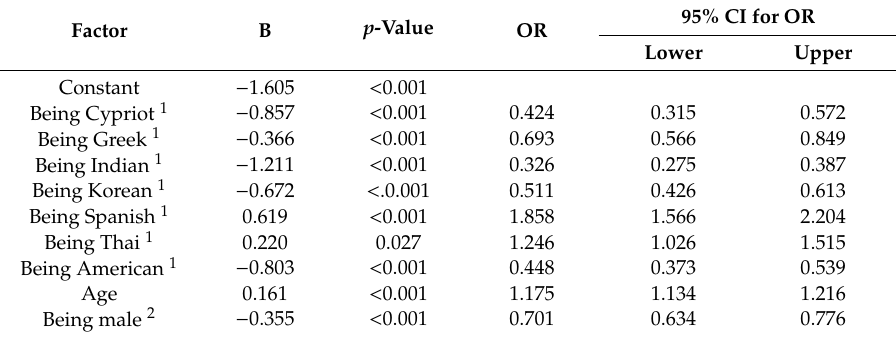
Table 3. Demographic predictors of being a bystander to online hate. OR, odds ratio.